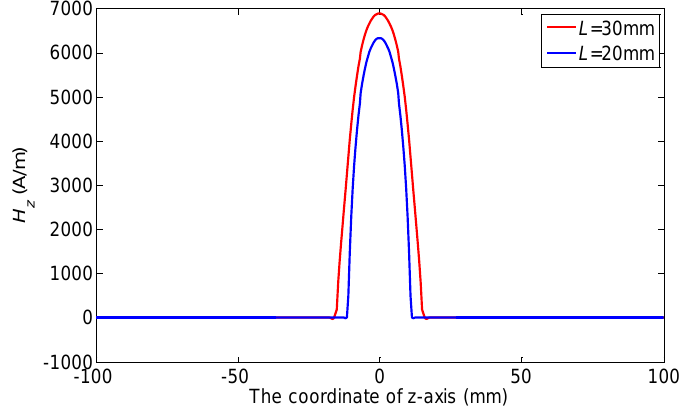
Figure 9. The alternating magnetic field produced by the special structure when L = 30